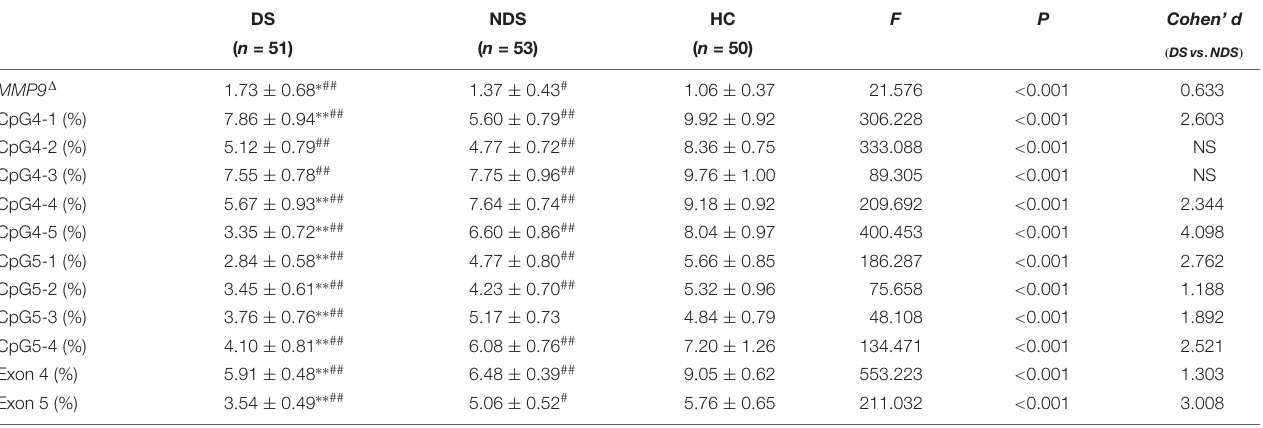
Values represented as mean ± S.D. DS, deficit schizophrenia; NDS, non-deficit schizophrenia; HC, healthy controls; BPRS, Breif Psychiatric Rating Scale; SAPS, the Scale for the Assessment of Positive Symptoms; SANS, the Scale for the Assessment of Negative Symptoms; CPZ, chlorpromazine; IQR, interquartile range. ∗∗ P < 0.001 DS vs. NDS. ( (cid:49) P ( < 0.01 DS vs. HC. TABLE 2 | Methylation of MMP-9 and gene expression in DS, NDS, and HC